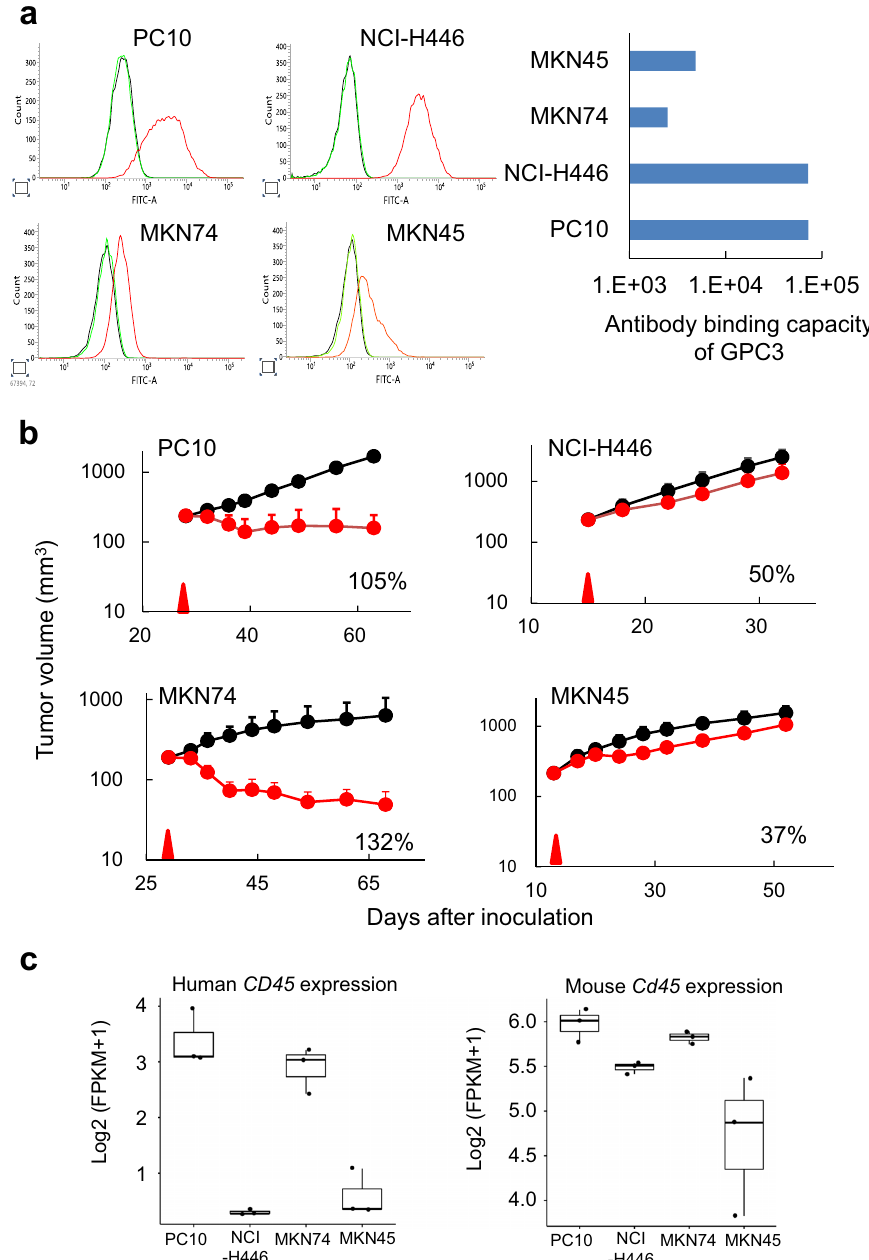
Fig.1|Thenumberofin fi ltratedimmunecellsatbaselineisapredictivemarker ofERY974ef fi cacyinthehuNOGmodel.a (Histogram)Cellsurfaceexpressionof GPC3 determined using fl ow cytometry with anti-GPC3 antibody ( n =1). Black line indicates a shift with no antibody; the green line indicates a shift with isotype control; the red line indicates a shift with an anti-GPC3 antibody. (Table) Antibody bindingcapacity(ABC)of GPC3invariouscelllineswithGPC3-high(PC10and NCI- H446) and GPC3-low (MKN74 and MKN45) expression. b Antitumour ef fi cacy of ERY974 (1mg/kg) in various tumour models ( n =5). During studies, one mouse in the vehiclegroup inthe PC10model wassacri fi ced due tobody weight loss on day 44, andonemouseinthe ERY974group intheMKN74modelwas sacri fi ceddueto